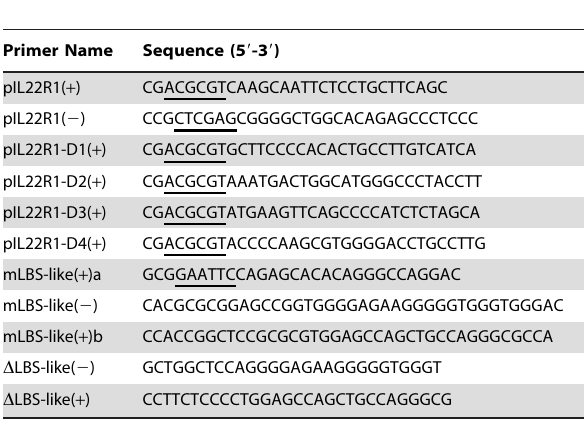
Table 1. Sequences of the primers used for the generation of luciferase reporter